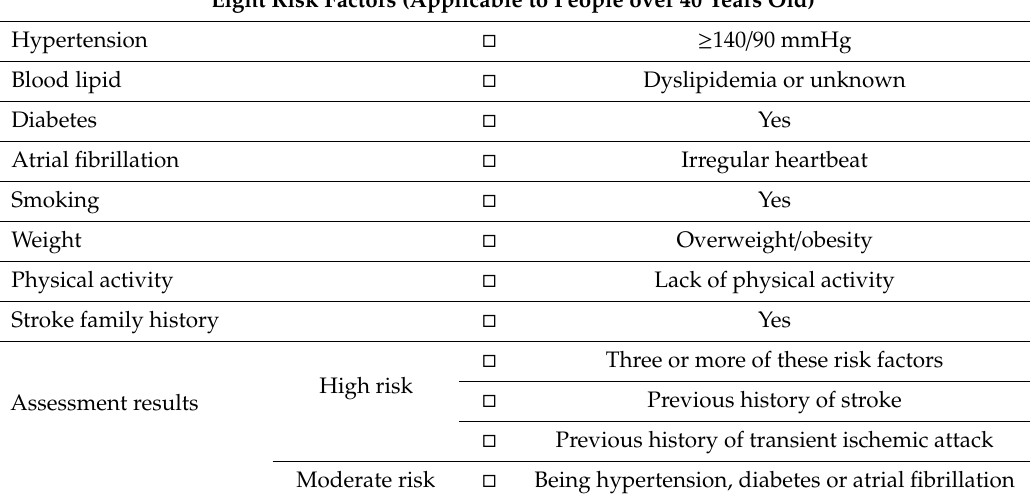
Table A1. Stroke risk score.